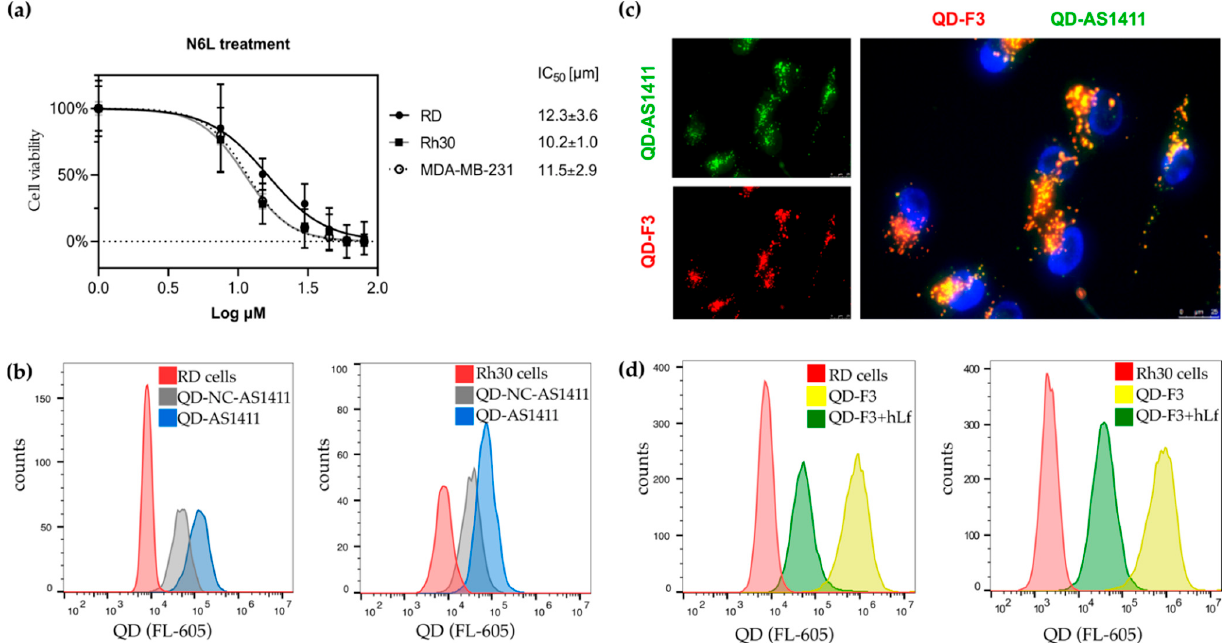
Figure 5. Validation of nucleolin presence on the surface of RMS cells by alternative nucleolin ligands. ( a ) The nucleolin antagonist N6L reduces RMS cells’ viability in culture. RMS cells (RD, Rh30) as well as MDA-MB-231 were incubated with increasing concentrations of N6L for 72 h. Cell viability was determined by the MTT assay, and the IC 50 of N6L was calculated. ( b ) The biotinylated aptamer AS1411, or its negative control NC-AS1411, were conjugated to QD-SA, and incubated overnight at 20 nM with RMS cells. QD-AS1411 shows increased binding to RMS cells compared to the mutated oligonucleotide QD-NC-AS1411. ( c ) 10 nM QD(525)-AS1411 and QD(605)-F3 were co-incubated with RD cells overnight. After washing and fixation, cells were analyzed with fluorescence microscopy. The image shows colocalization of QD-F3 (red) and QD-AS1411 (green) after binding and internalization on RD cells. ( d ) Co-incubation with human lactoferrin, a high-affinity natural ligand of nucleolin, leads to decreased binding of QD-F3 to the RMS cells RD and Rh30. Cells were detached, pre-incubated with 2 μ M lactoferrin for 20 min, and then co-incubated with 20 nM QD-F3 on ice for 1 h.